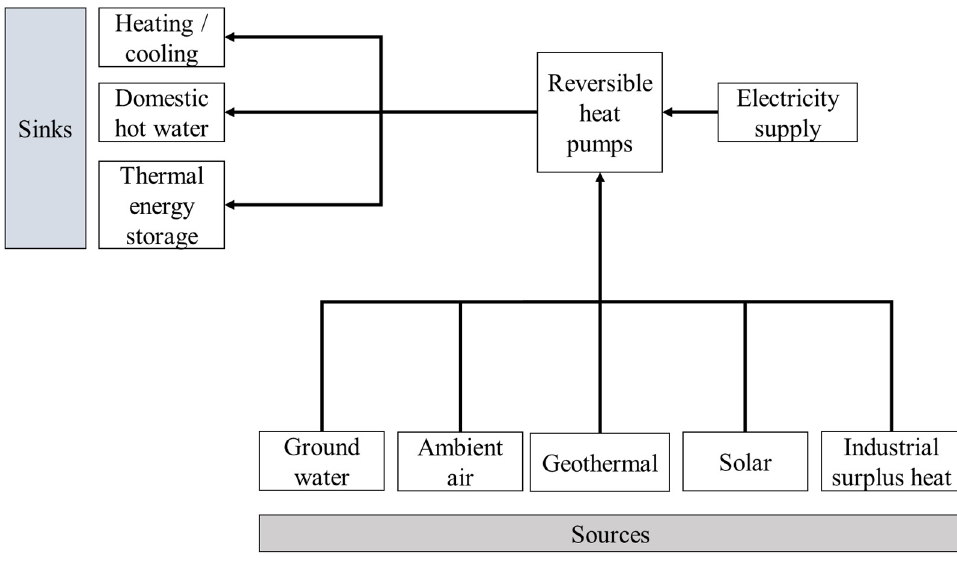
Figure 5. Operation of heat pumps with typical heat sources and sinks of DHC.